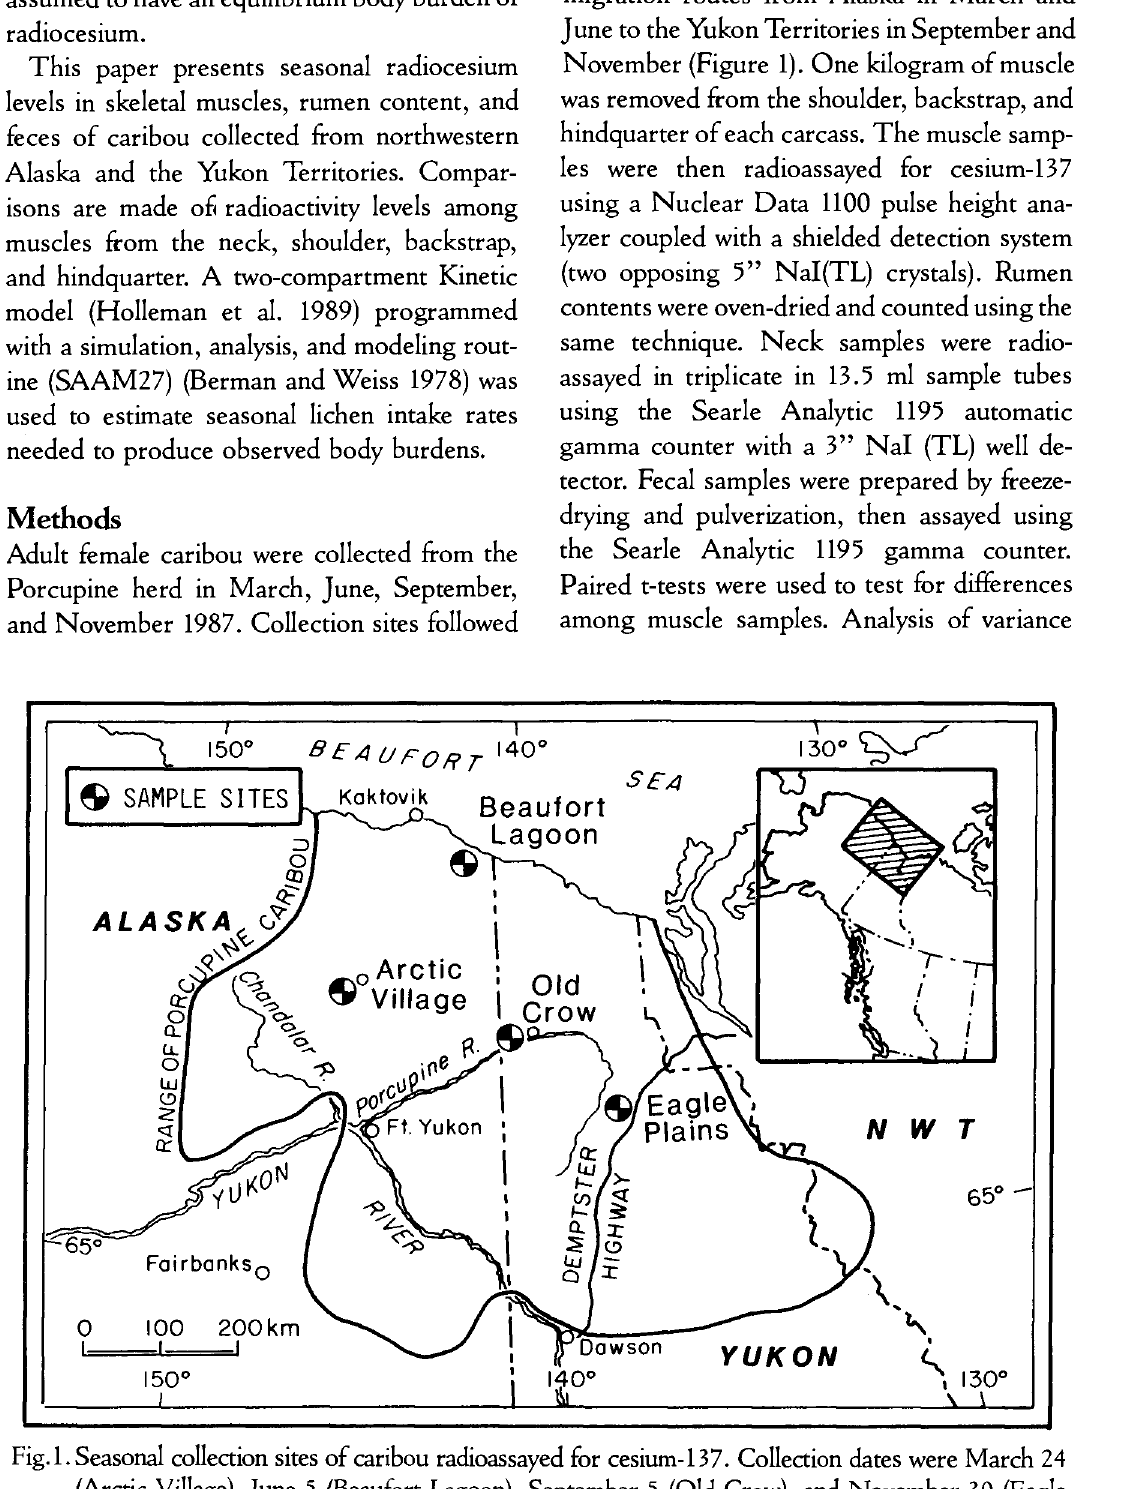
Fig. 1. Seasonal collection sites of caribou radioassayed for cesium-137. Collection dates were March 24 (Arctic Village), June 5 (Beaufort Lagoon), September 5 (Old Crow), and November 30 (Eagle